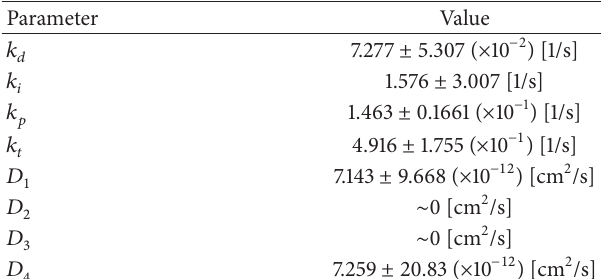
Figure 5: LMA procedure. Table 5: Estimated medium